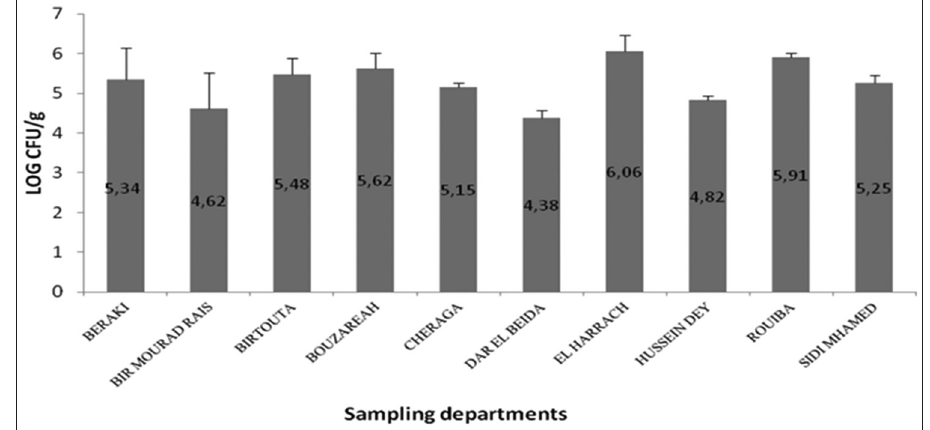
Figure-2: The average values of Staphylococcus aureus counted in sausages according to the sampling departments. Table-2: Antibiotic resistance of S. aureus isolated from sausage (n=84). Antibiotic